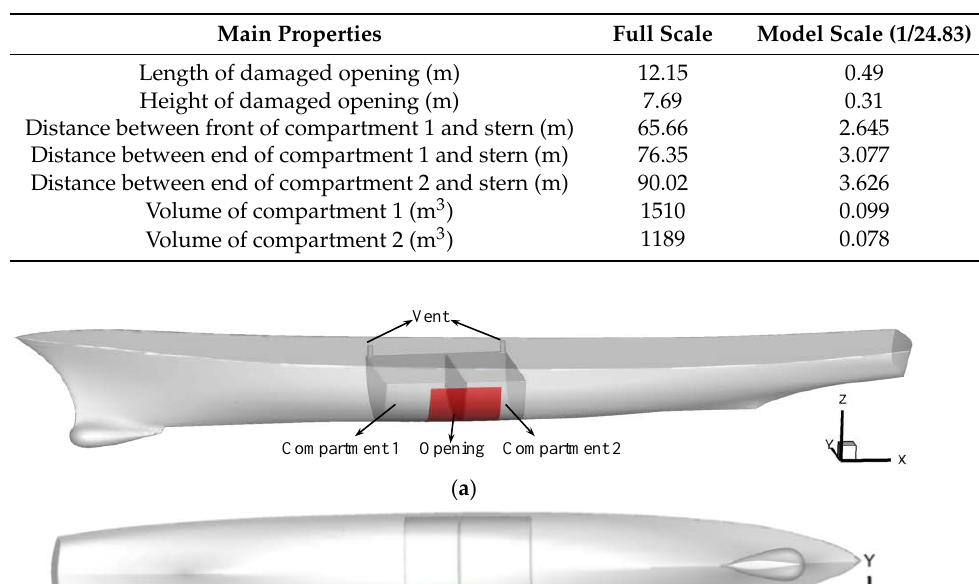
Table 2. Properties of the damaged compartments.